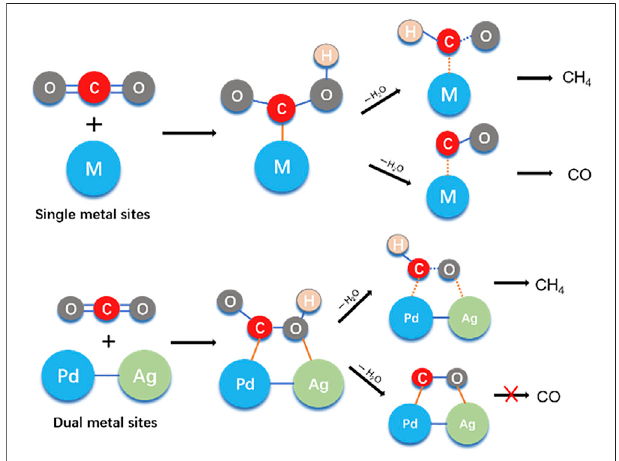
SCHEME 1 | The modulated CO 2 reduction process on single and dual metal